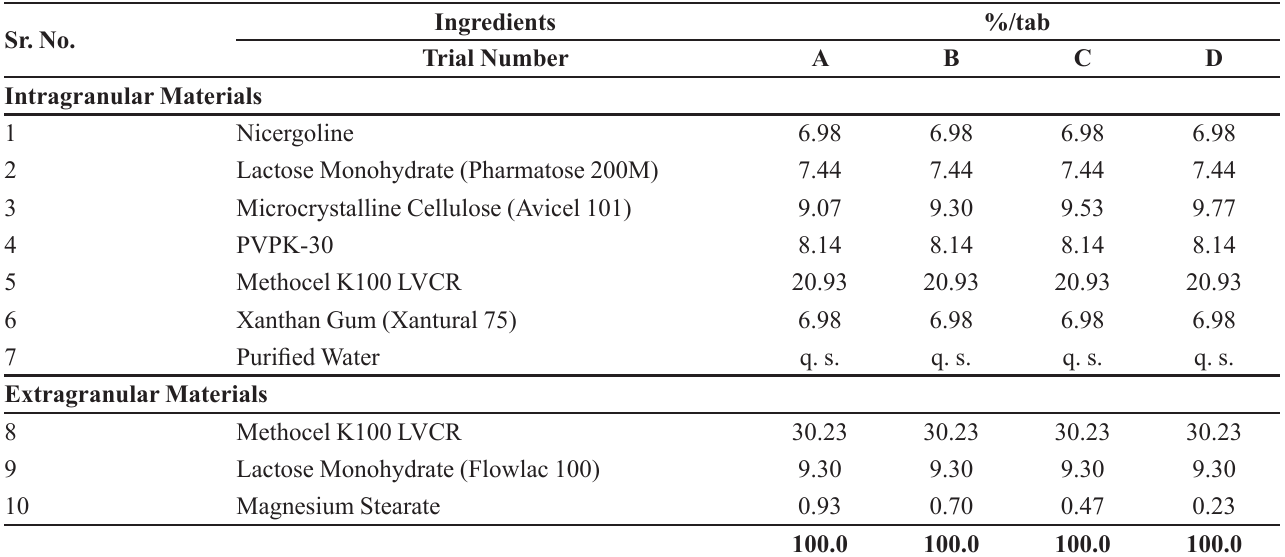
TABLE I - Unit formula composition Sr.